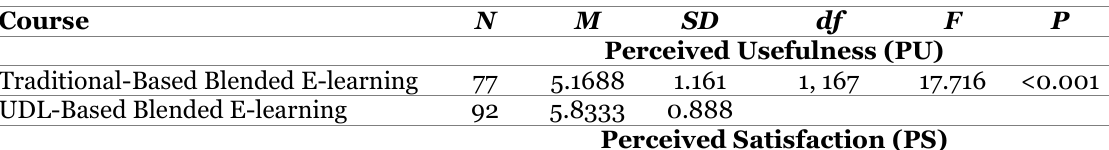
A Comparison Between PU, PS, and ITU of the Experimental and Control Groups (one-way ANOVA) Course N M